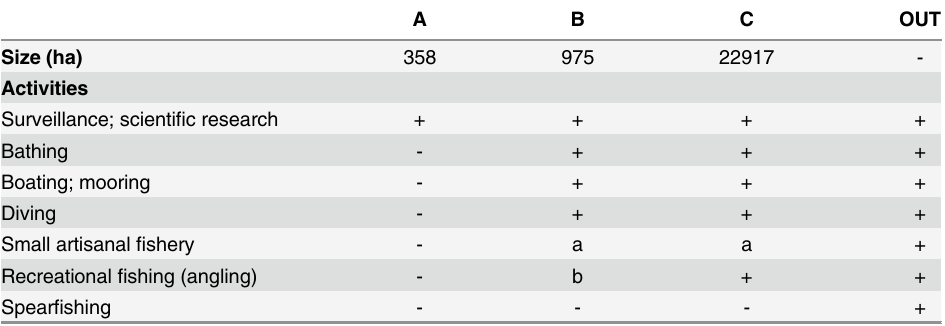
Table 1. List of the activities permitted in the different protection zones of the Sinis